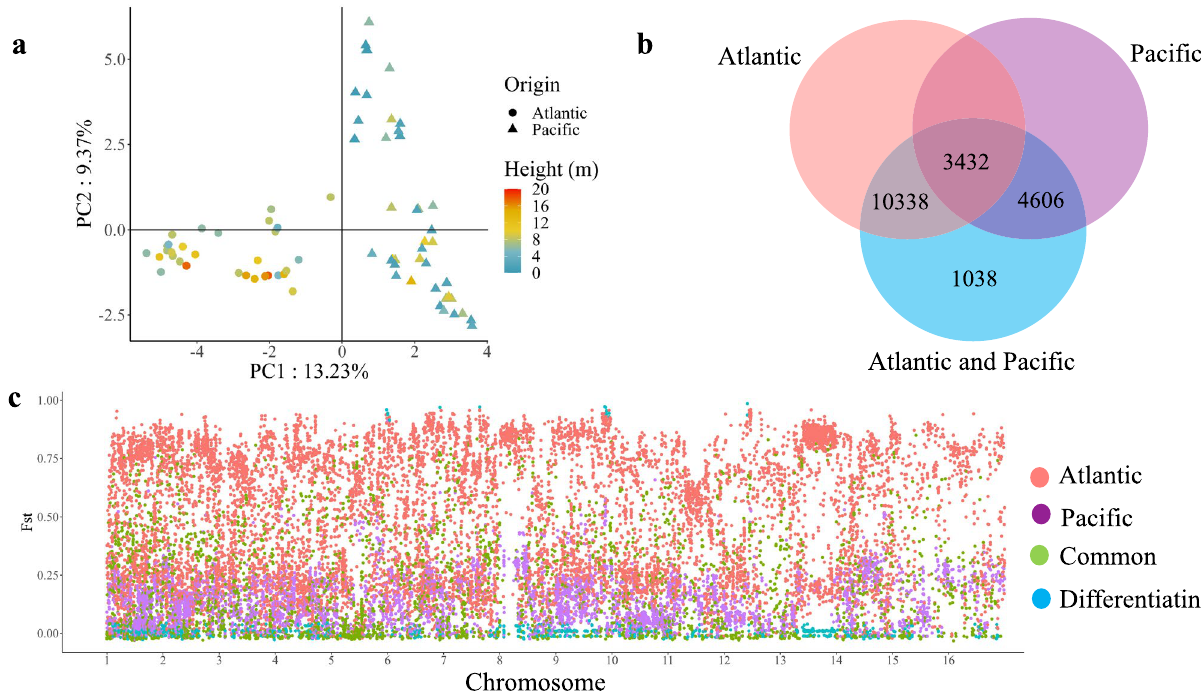
Figure 2. Genetic differentiation between Colombian Atlantic and Pacific coast coconut gene pools. ( a ) Principal component analysis of 99 accessions from the Atlantic and Pacific coast including different commercial groups. ( b ) Venn diagram of the total set of SNPs (19,414) and SNPs belonging to the Atlantic and Pacific groups. ( c ) Distribution of the Fst values of each